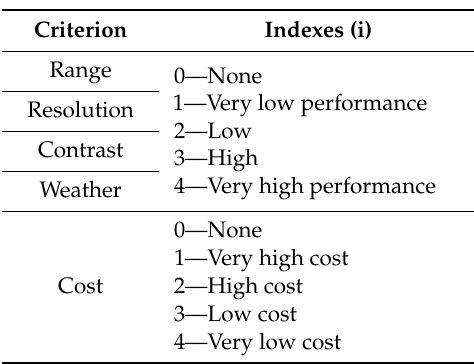
Table 1. Indexes to interpret spider